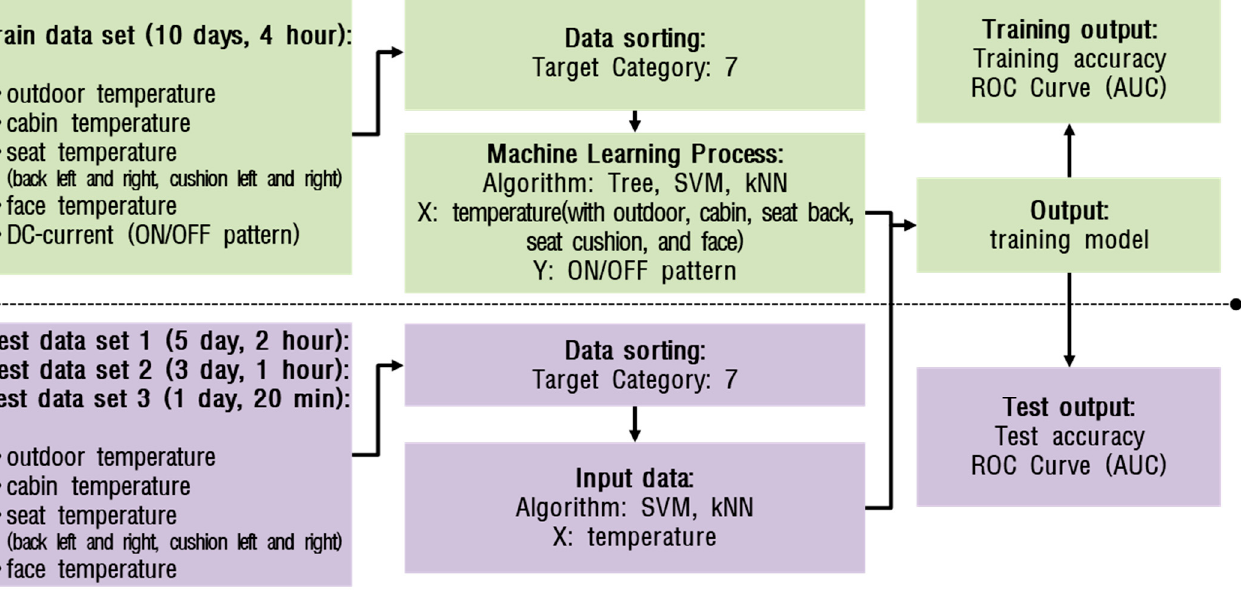
Figure 6. Input and output features used for personal thermal-comfort pattern model.